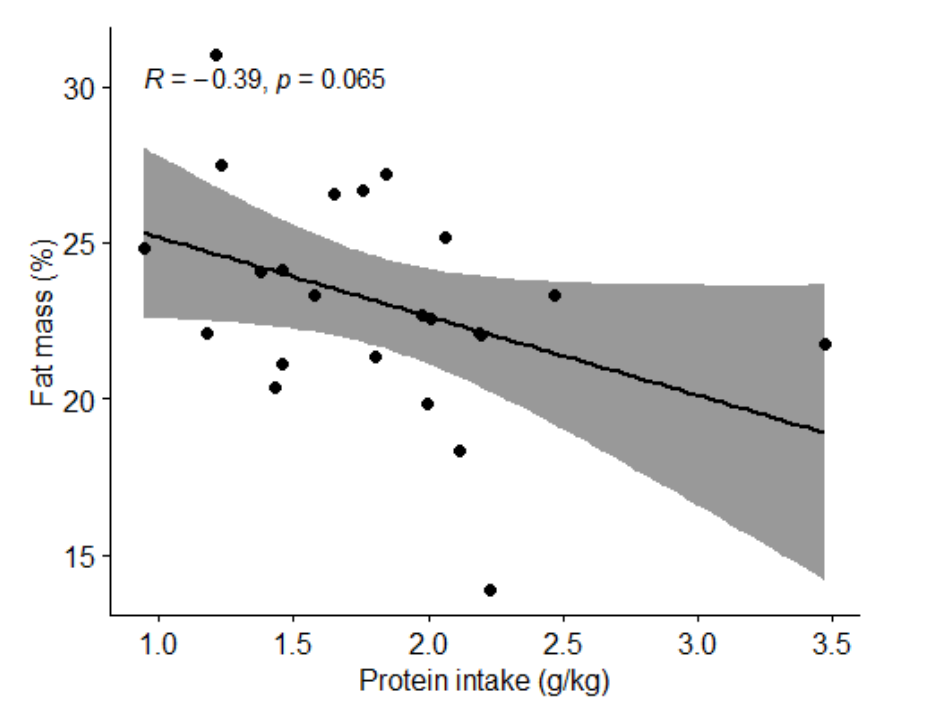
Figure 10. Correlation between protein intake and body fat percentage in football players. Dots represent individual participants ( n = 23). Grey shaded area indicates 95% CI.